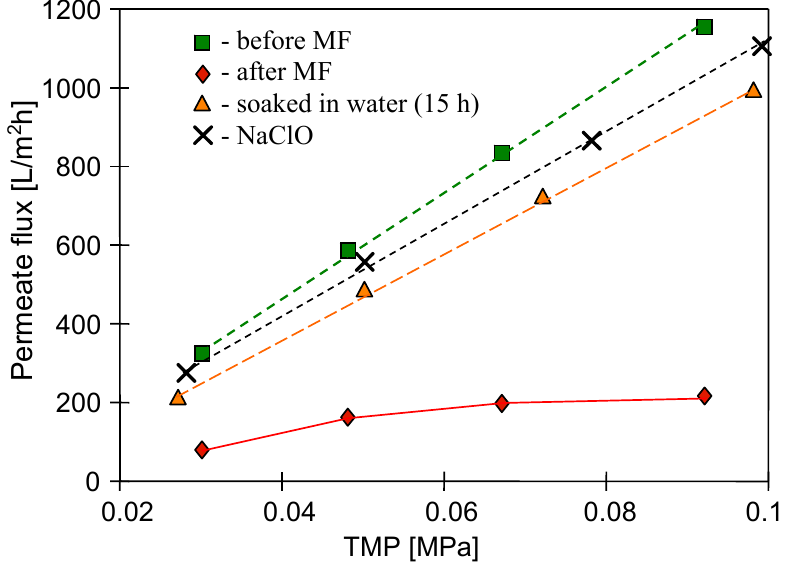
Figure 16. Variations in permeate flux during membrane cleaning after MF of oily wastewater #1.